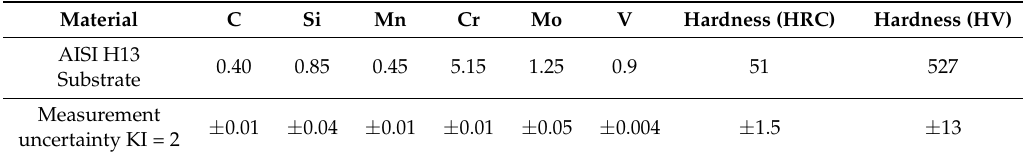
Table 3. Chemical composition (wt %) and hardness of the AISI H13 plate.